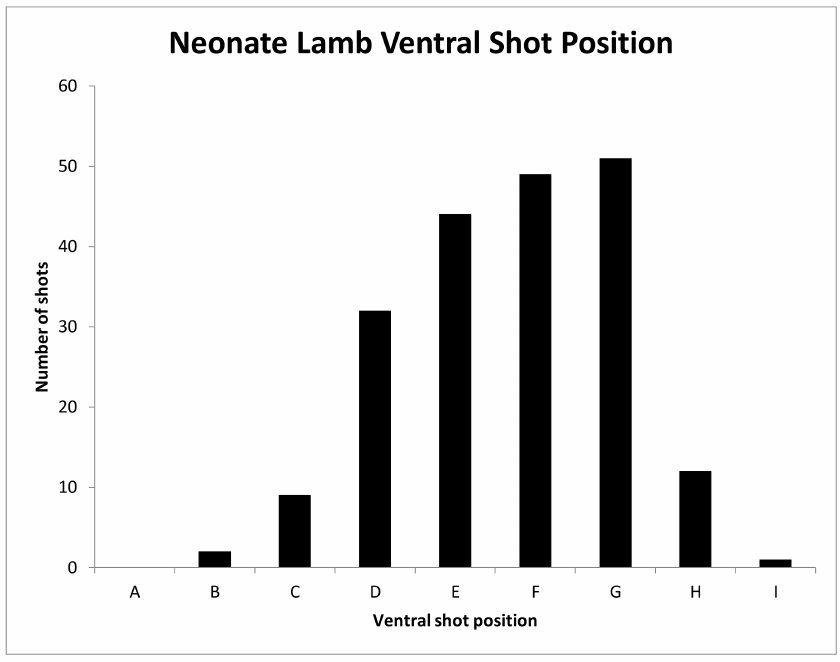
Figure 10. Graph of ventral shot position over the 200 lambs subjectively scored based on the ventral targeting position indicator in Figure 3.